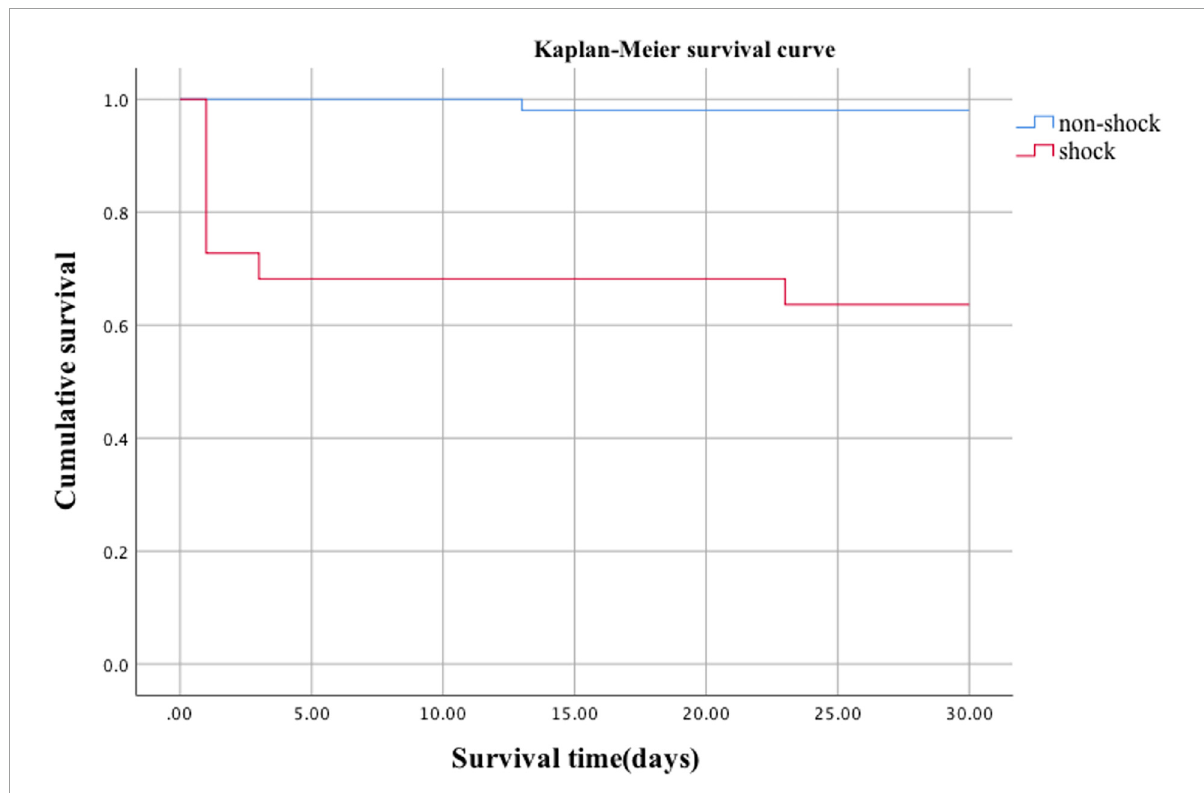
FIGURE3 Survival analysis curve of organophosphorus poisoning-induced shock.